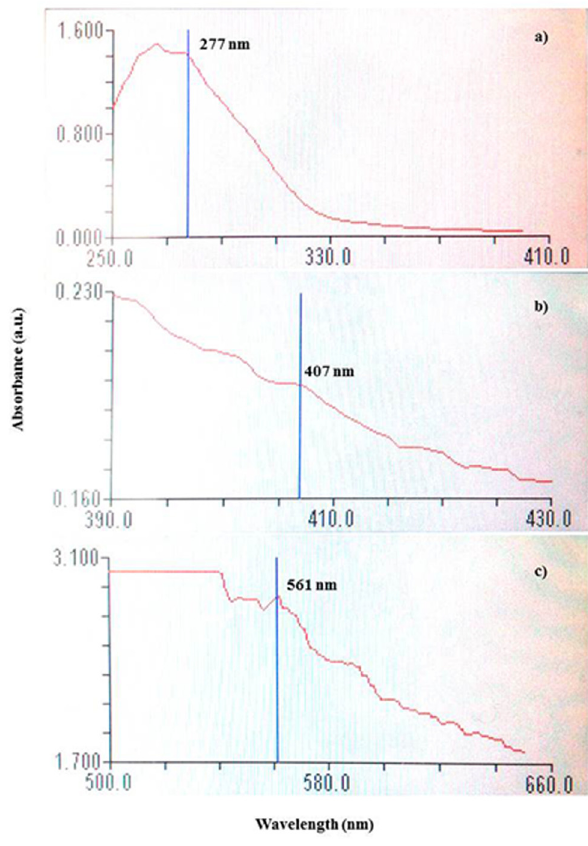
Figure 2: UV - Vis spectra of the solutions containing Se NPs ( a ) , Ag NPs ( b ) and Au NPs ( c ) .